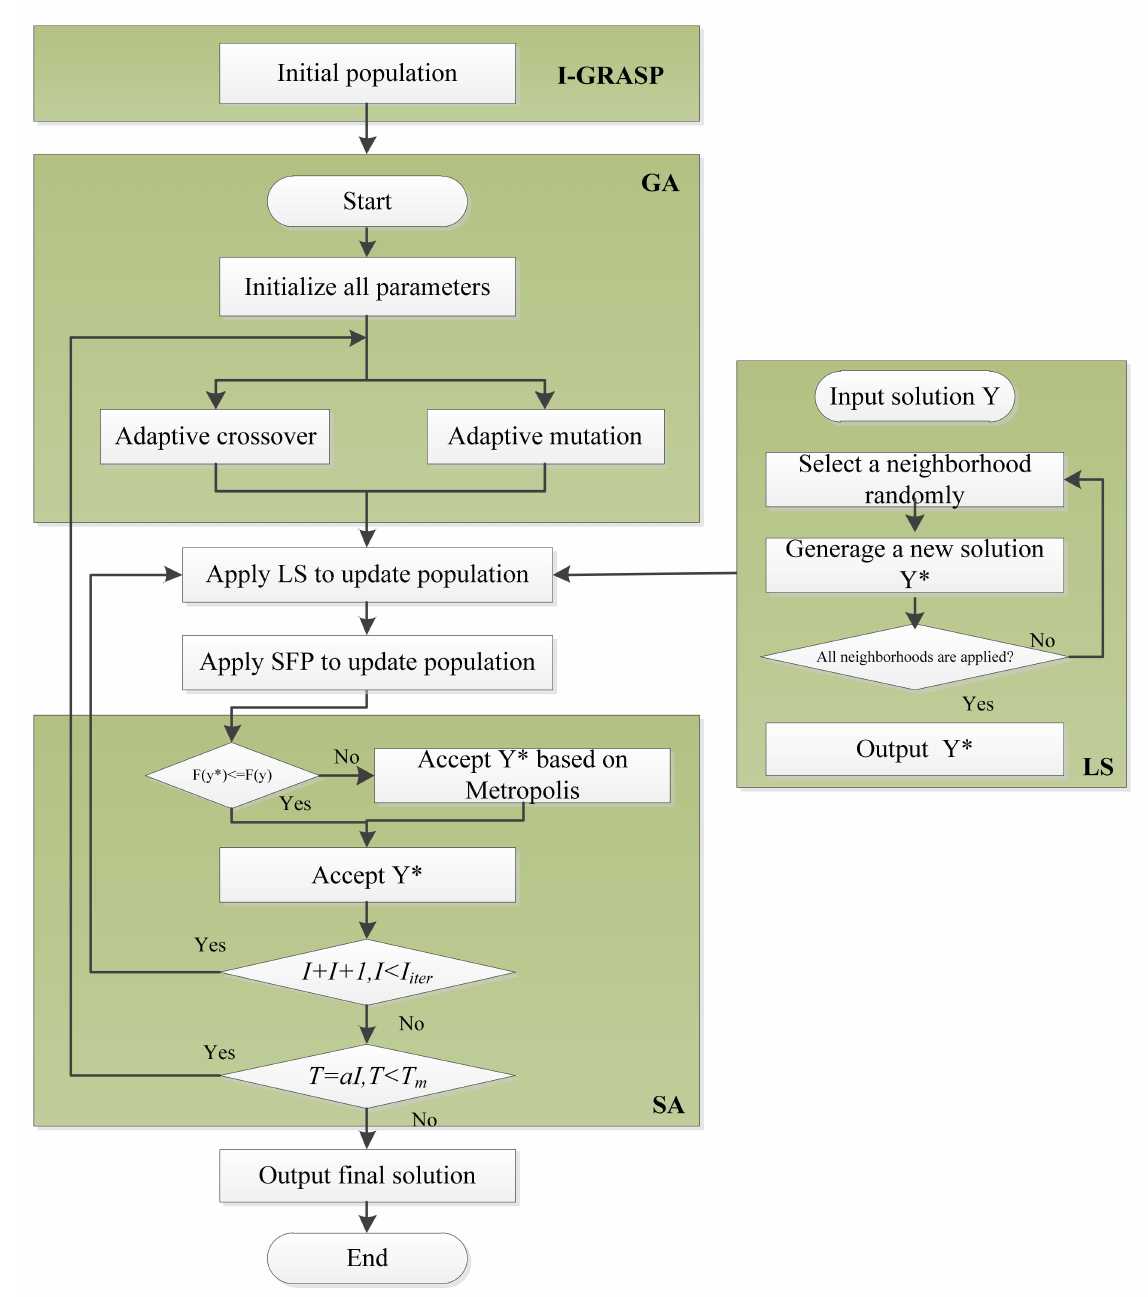
Figure 1. The flowchart of our